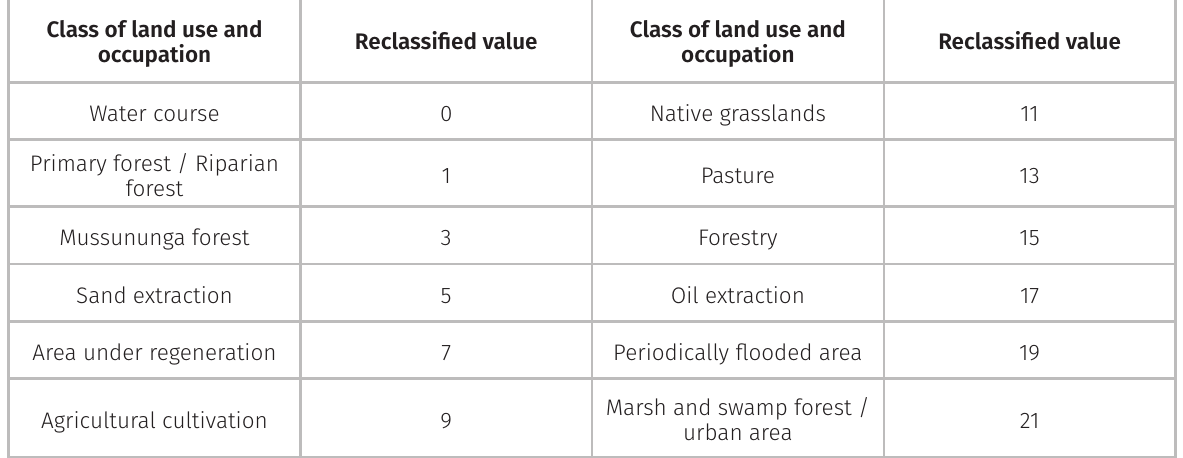
Table I. Land use and occupation classes reclassified as a function of the potential for risk of forest fires. Class of land use and